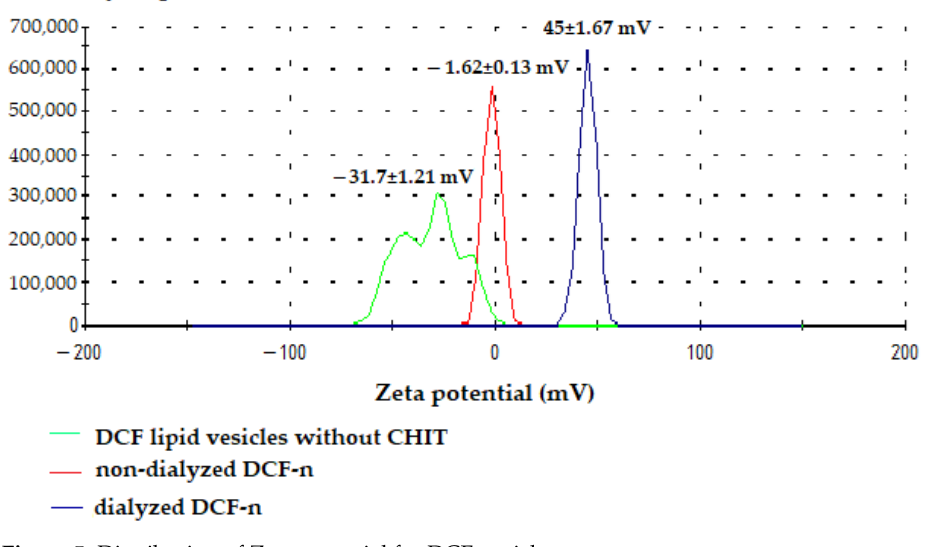
Figure 5. Distribution of Zeta potential for DCF-vesicles.